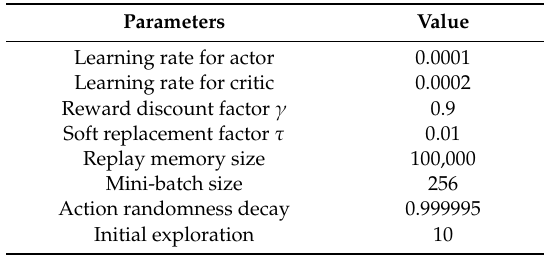
Table 1. DDPG parameters.